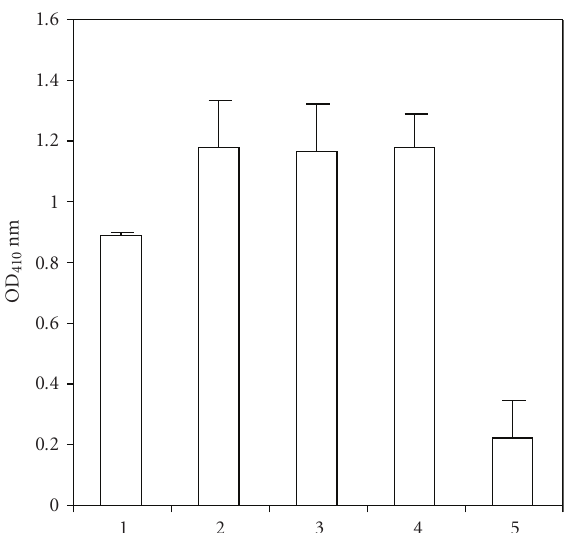
Figure 3: Testing 4 a ffi nity purified human IgG anti-dsDNA antibodies in binding to the purified bacterial antigen in ELISA. ELISA plates were coated with the purified bacterial antigen (50 μ g/mL). Lanes 1–4 contain purified anti-dsDNA antibodies (1 μ g/100 μ L) binding to purified bacterial antigen and lane 5 has CF II as control binding to purified bacterial antigen. Anti human IgG Fc fragment specific alkaline phosphatase conjugate was used to detect anti-dsDNA antibody binding. The data were expressed as the mean ± SD.